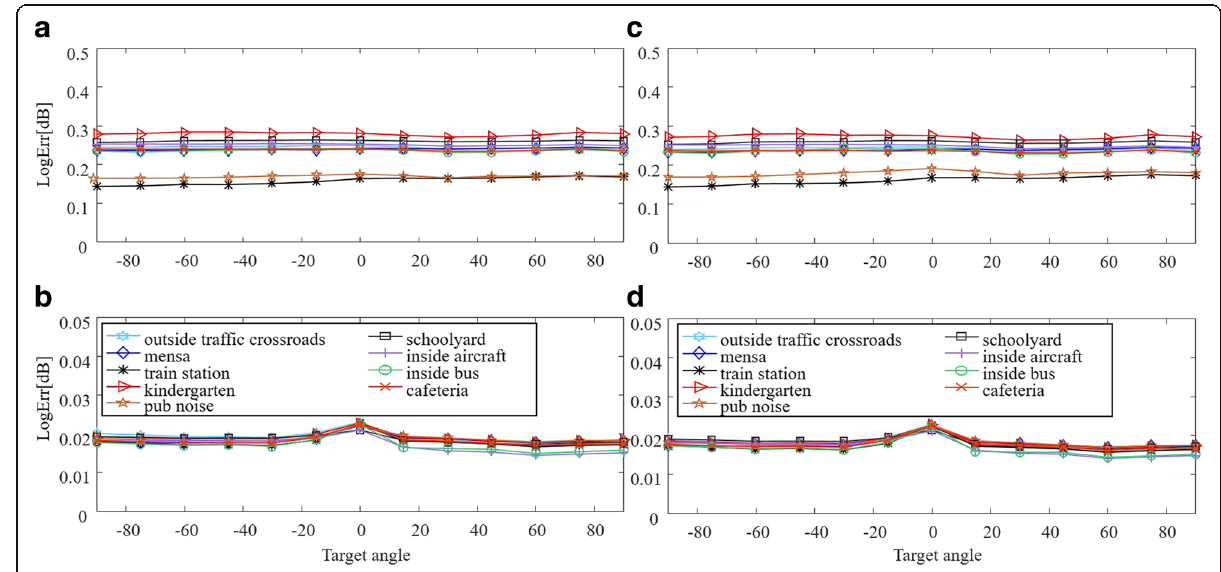
Fig. 3 LogErr measured for various types of noise under a 0 dB and c 5 dB at low frequencies (below 1 kHz) and b 0 dB and d 5 dB at high frequencies (from 1 to 8